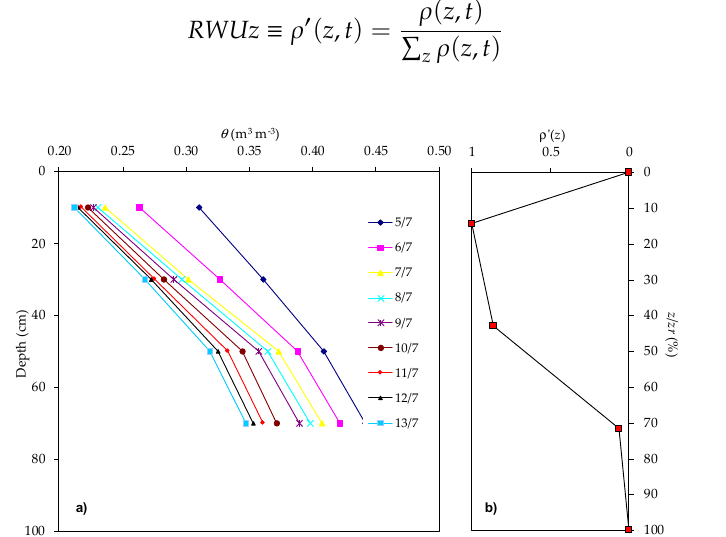
Figure 2. Measured soil water content profiles from 5 to 13 July ( a ) and root density profile ( b ) in a watermelon field.